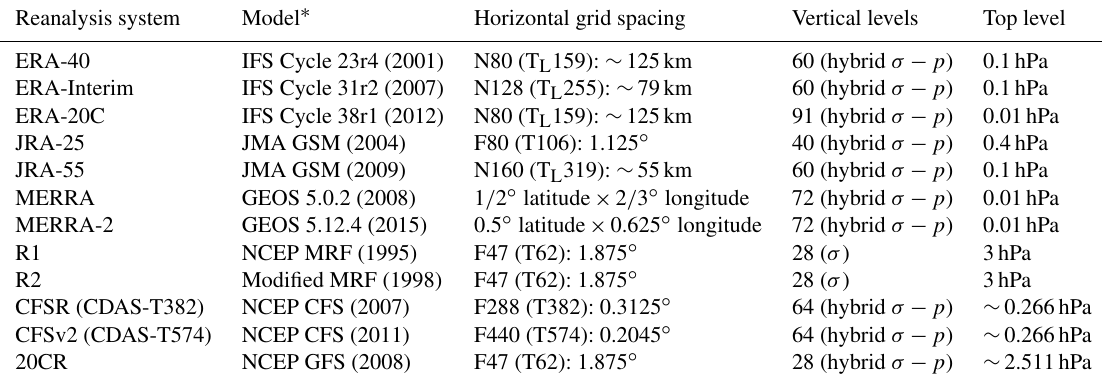
Table 2. Basic specifications of the reanalysis forecast models. Approximate longitude grid spacing is reported in degrees for models with regular Gaussian grids (F n ) and in kilometres for models with reduced Gaussian grids (N n ). Wavenumber truncations for models with Gaussian grids are reported in parentheses.